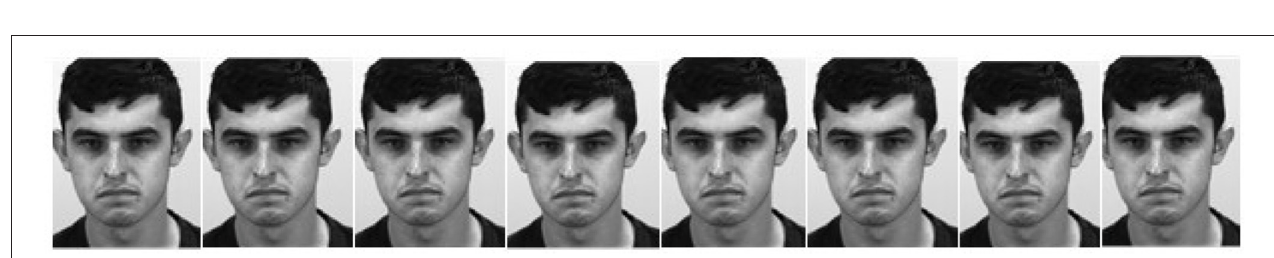
FIGURE 4 | Sample frames from a sequence (Subject 6) in SAMM that contains micro-movements. Images reproduced from the database with permission from Davison et al.